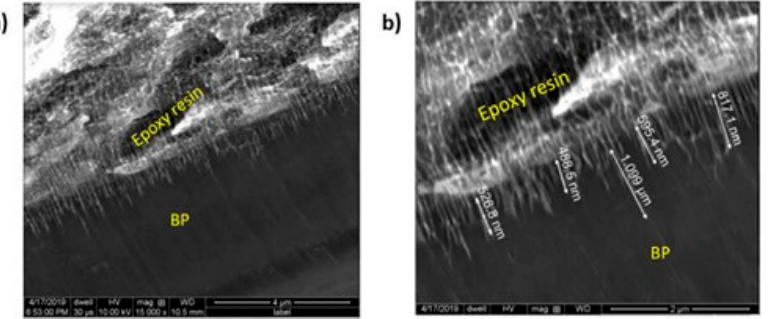
Figure 10. ( a ) Image of the interface formed from a BP coated with epoxy resin (coated side is the upper layer) at ×15,000 and ( b ) ×30,000